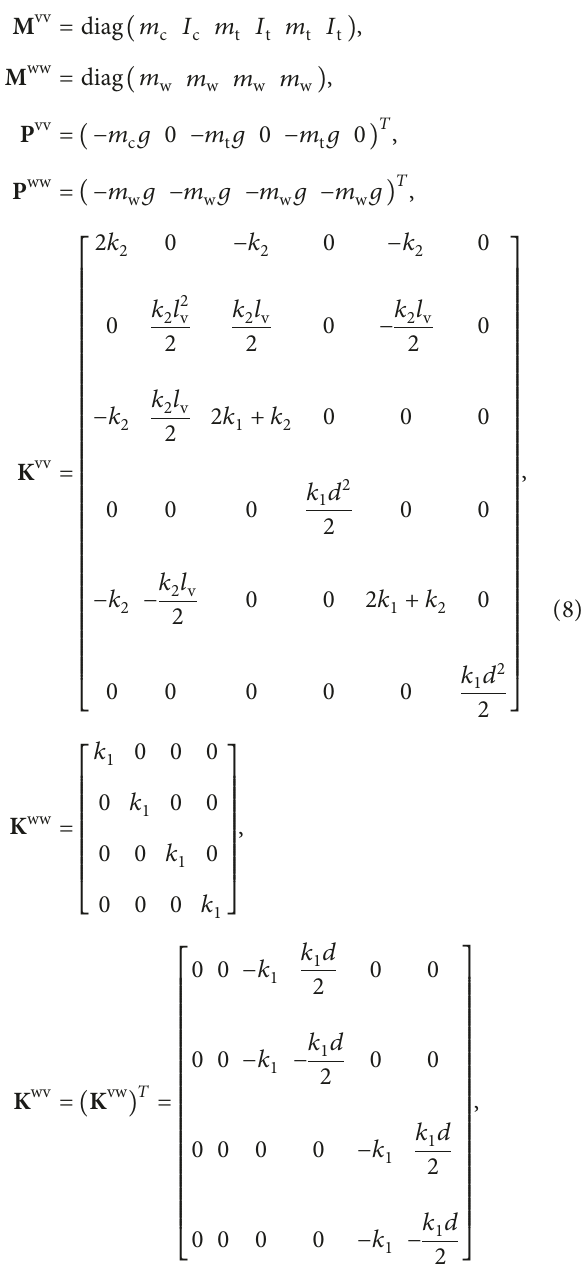
u v u v u v 7 8 9 10